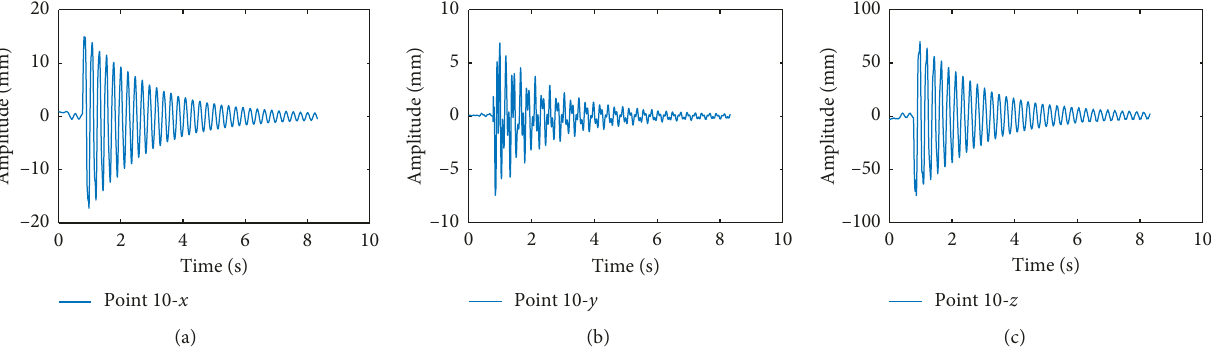
Figure 7: Vibration displacement curves of point 10 under impact excitation: (a) X direction, (b) Y direction, and (c) Z direction.